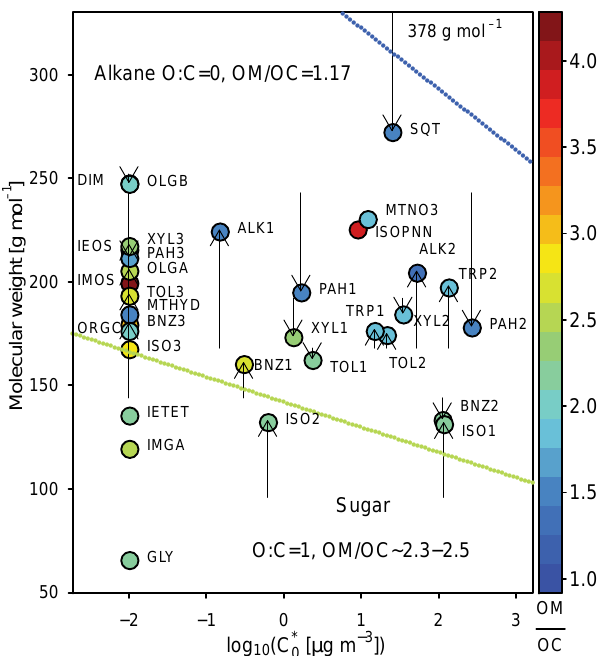
Figure 4. The volatility, molecular weight, and OM / OC of SOA species in CMAQ. Nonvolatile species are arbitrarily plotted at a saturation concentration of 0.01 µgm − 3 . The arrows start at the old molecular weights assumed in CMAQ v5.1. The arrows end at the new (CMAQ v5.2) molecular weights in Table 2. Lines indicate the properties of alkanes and sugars. The molecular weight of sesquiter- pene SOA in CMAQ v5.1 is off the scale at 378gmol − 1